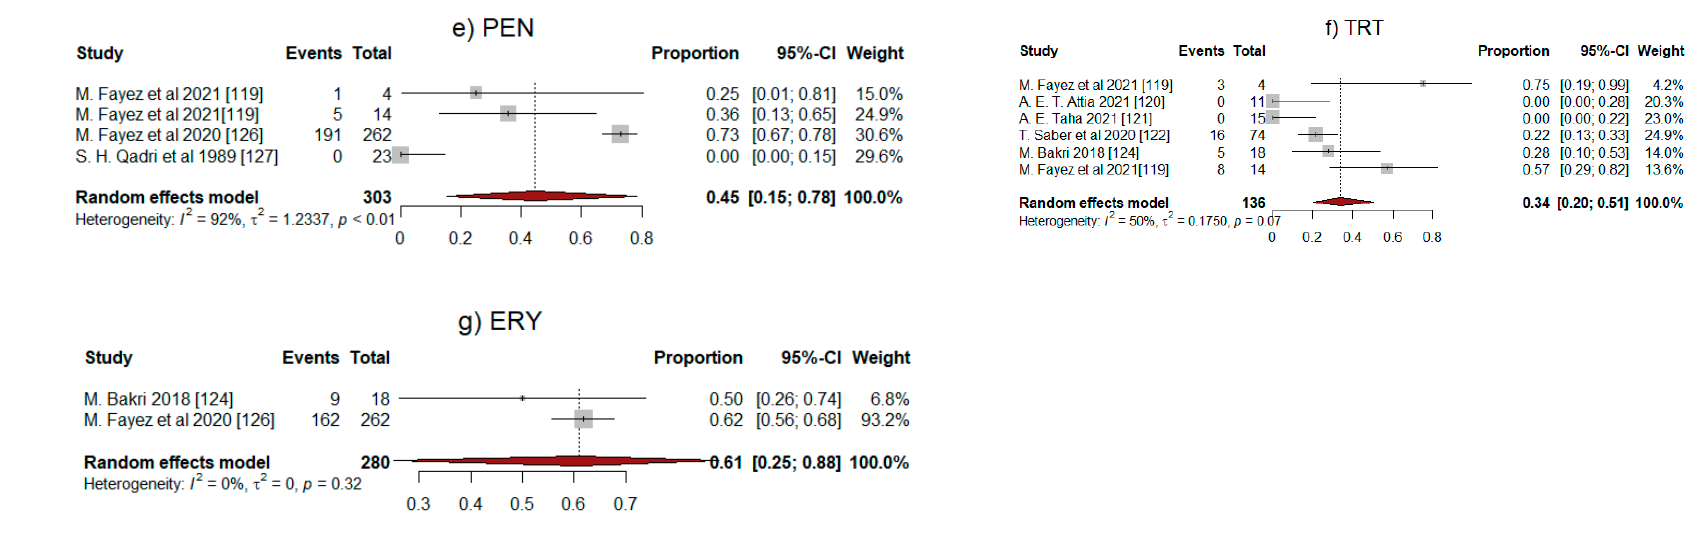
Figure 2. Forest plots of the random-effects meta-analysis of the ten works included in this study. ( a ) CIP, ( b ) MTZ, ( c ) CLI, ( d ) LVX, ( e ) PEN, ( f ) TRT, ( g ) ERY.